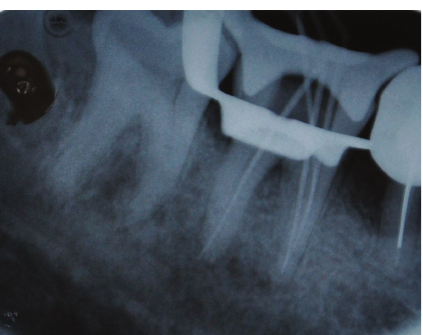
Figure 4: Master